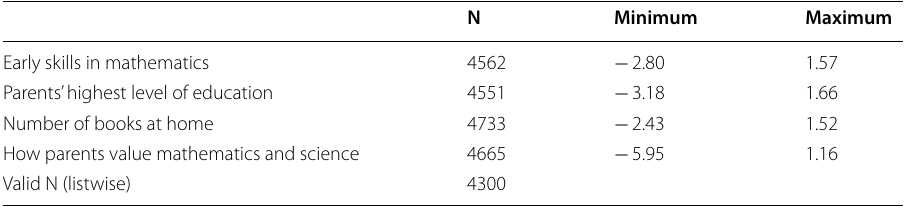
Table 1 Variables used in the models